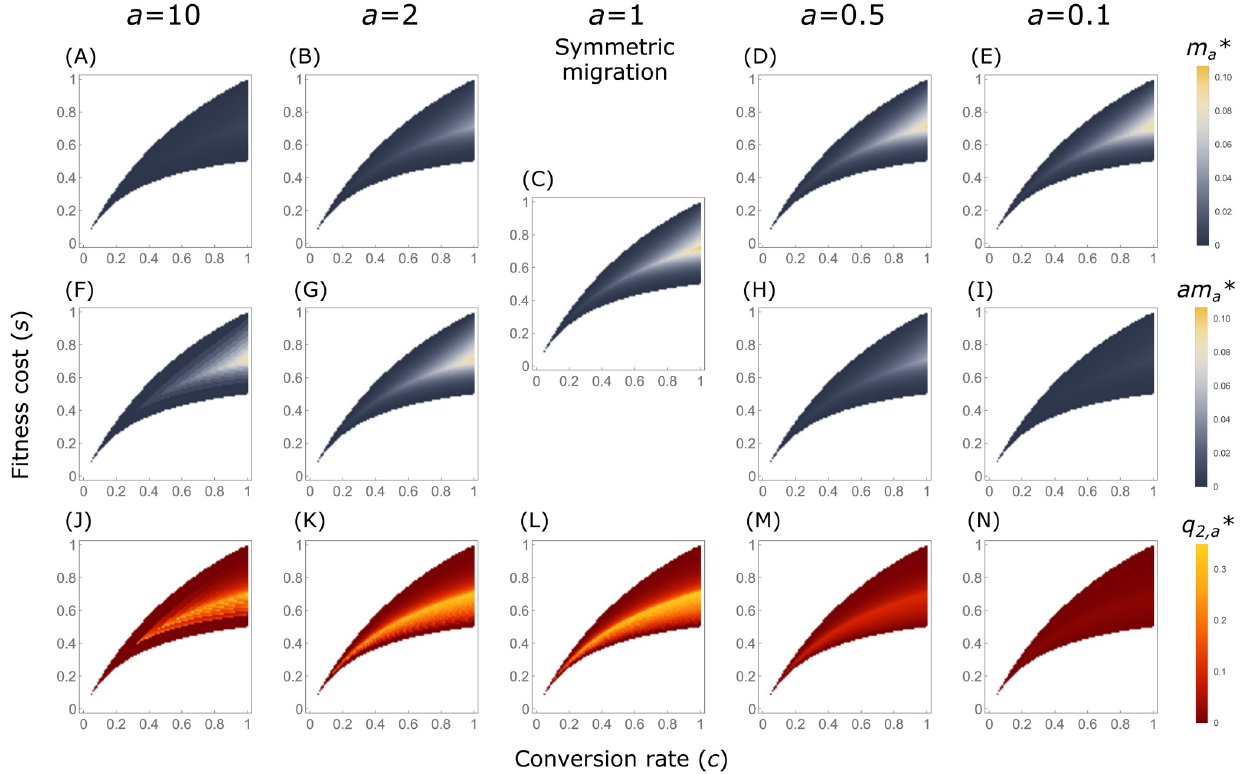
Fig 6. Critical migration thresholds for differential targeting, m � asymmetric migration, for additive gene drives ( h = 0.5). (A–E) Critical migration thresholds from the non-target deme to the target deme, m � migration ratio a . (F–I) Critical migration thresholds expressed as migration from target to non-target demes, am � gene-drive frequencies in the non-target population at the at DTE, q �